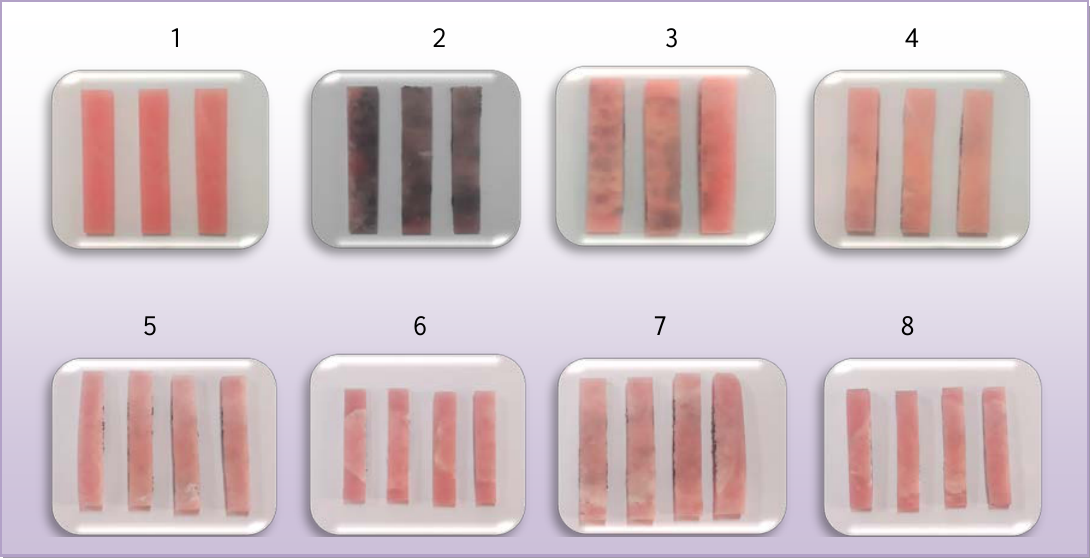
Fig.3: manufactured samples